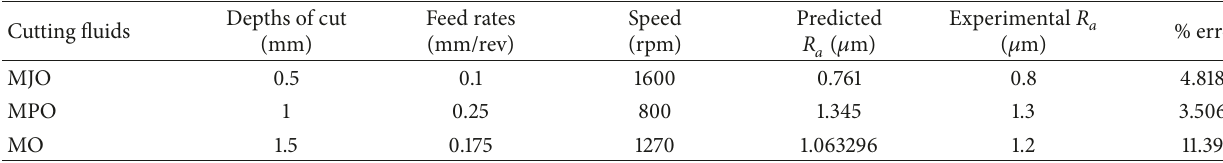
Table 8: Confirmation tests for surface